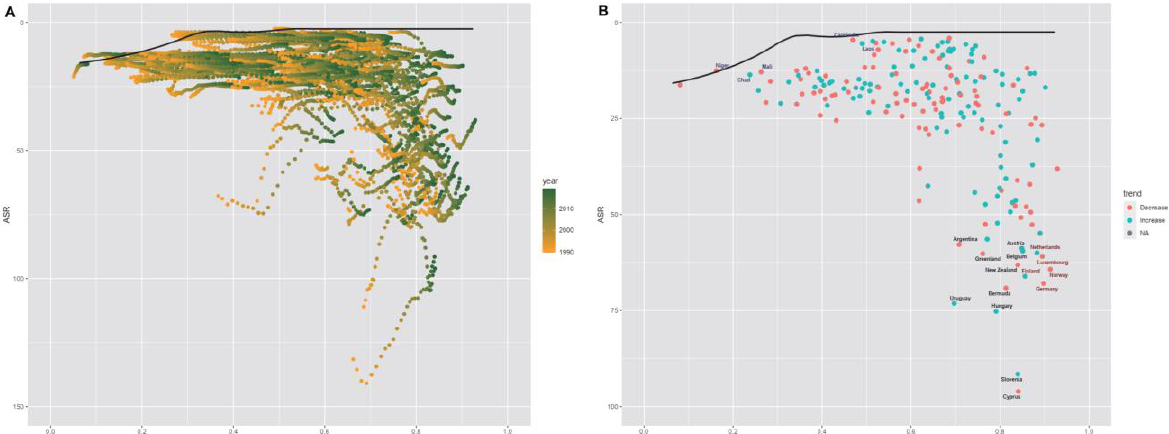
Figure 4. ( A ) Frontier analysis based on SDI and age-standardized nrCAVD DALYs rate from 1990 to 2019. The frontier is delineated in solid black color; countries and territories are represented as dots. ( B ) Frontier analysis based on SDI and age-standardized nrCAVD DALYs rate in 2019. The top 10 countries with the largest effective difference (largest nrCAVD DALYs gap from the frontier) are labeled in black; examples of frontier countries with low SDI (<0.5) and low effective difference are labeled in blue (e.g., Chad, Niger, Mali, Cambodia, and Laos); and examples of countries and territories with high SDI (>0.85) and relatively high effective difference for their level of development are labeled in red (e.g., Netherlands, Finland, Luxembourg, Germany, and Norway). Red dots indicate an increase in age-standardized nrCAVD DALYs rate from 1990 to 2019; blue dots indicate a decrease in age-standardized nrCAVD DALYs rate between 1990 and 2019. DALYs, disability-adjusted life years; SDI, socio-demographic index; nrCAVD, non-rheumatic calcific aortic valve disease.